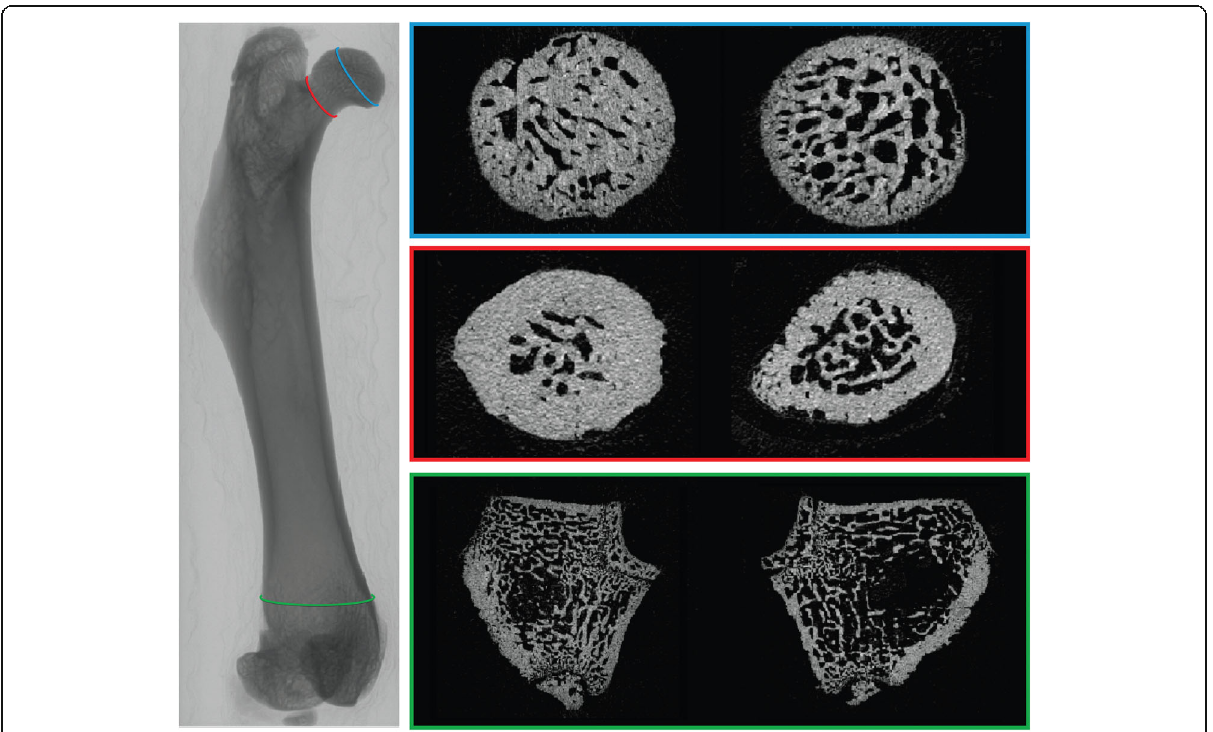
Fig. 1 Comparison of trabecular bone between a Zucker lean rat (ZL, left) and a Zucker diabetic fatty rat (ZDF, right). Axial images of the femoral head, neck, and distal metaphysis. Decreased bone volume and trabecular number in ZDF rats compared to ZL rats, in the three volumes of interest